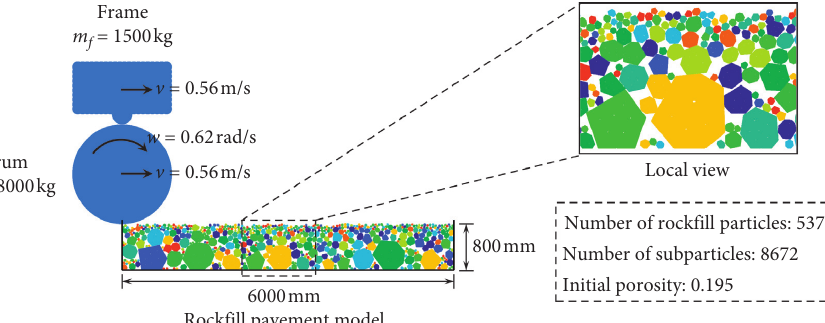
Figure 12: Discrete model of the vibratory roller compaction of field rockfills (Case